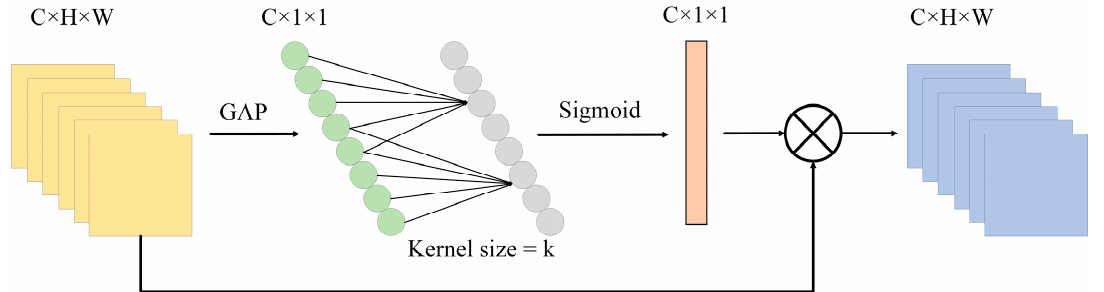
Figure 2. The detailed internal structure of the efficient channel attention module (ECA). “ C × ( H × W )” means that the number of input channels is C , the height of the convolution kernel is H , and the width of the convolution kernel is W . “ C × 1 × 1” means that the size of the convolution kernel is 1 × 1, and the number of input channels is C .